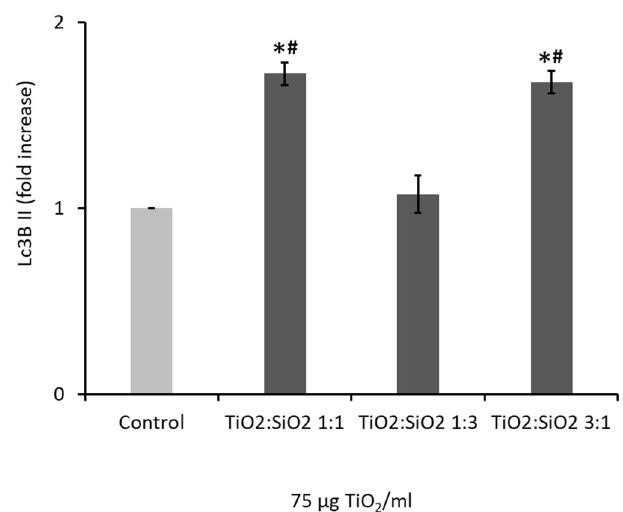
Figure 7. Autophagy was investigated through the analysis of the expression of LC3B II protein by cytofluorimeter. Cells were stained with LC3B II antibody after 24 h exposure to TiO 2 :SiO 2 NPs (75 μg TiO 2 /mL). The histograms represent the fold change of LC3B II expression over control, and they are the mean ± SE of at least three independent experiments. * Statistically significant with respect to control; # Statistically different from sample TiO 2 :SiO 2 1:3; t -test + Bonferroni’s post hoc test; p < 0.05.